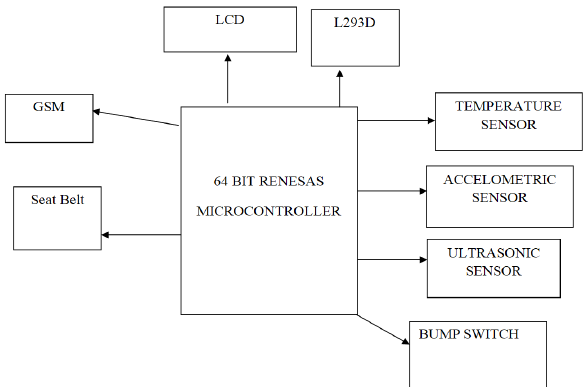
Figure 1. Block diagram of Black box for car